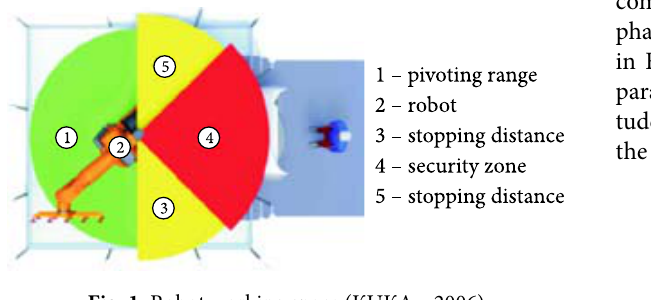
Fig. 1. Robot working space (КUКА...